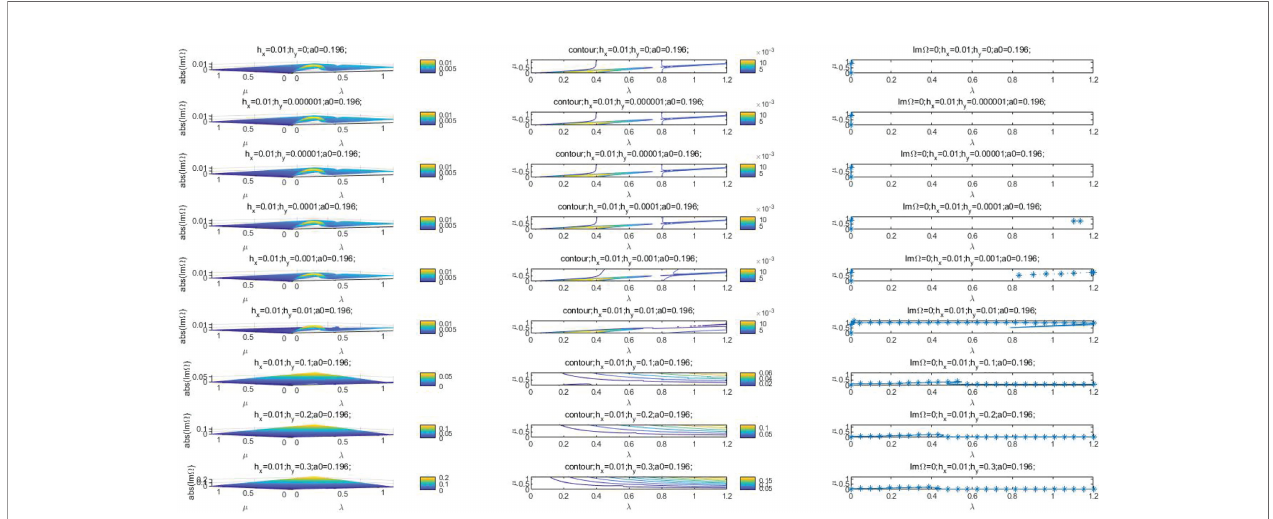
FIGURE 9 | Curves of ǀ Im W ǀ and Im W = 0 for a 0 = 0.196 and ∂ h ∂ x = 0 : 01.